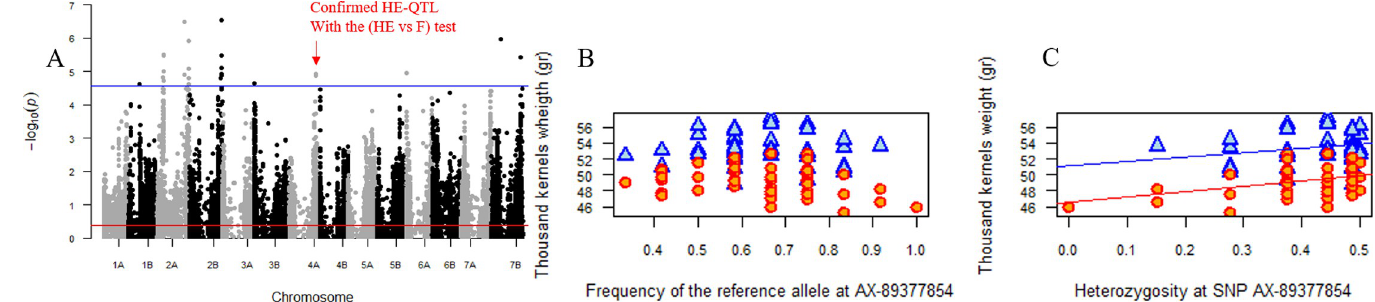
Fig 4. Positive impact on thousand-kernel weight (TKW) of the genetic diversity at the SNP “AX-89377854” located on the chromosome 4A. (A) Manhattan plot reporting p-values (-log10 transformed) for the association tests between TKW and diversity at 31k eligible SNPs distributed along the durum wheat genome (GWDA). The solid blue line represents the Family-Wise Error Rate (FWER) of 5% computed with the Galwey method. (B) Association between the allelic frequency of the SNP “AX-89377854” and TKW. Red points corresponds to plots under controlled water deficit conditions. Blue points corresponds to plots under rain-fed conditions (C) Relation between the genetic diversity of the SNP “AX-89377854” and TKW. Lines represent the slopes of the regression.